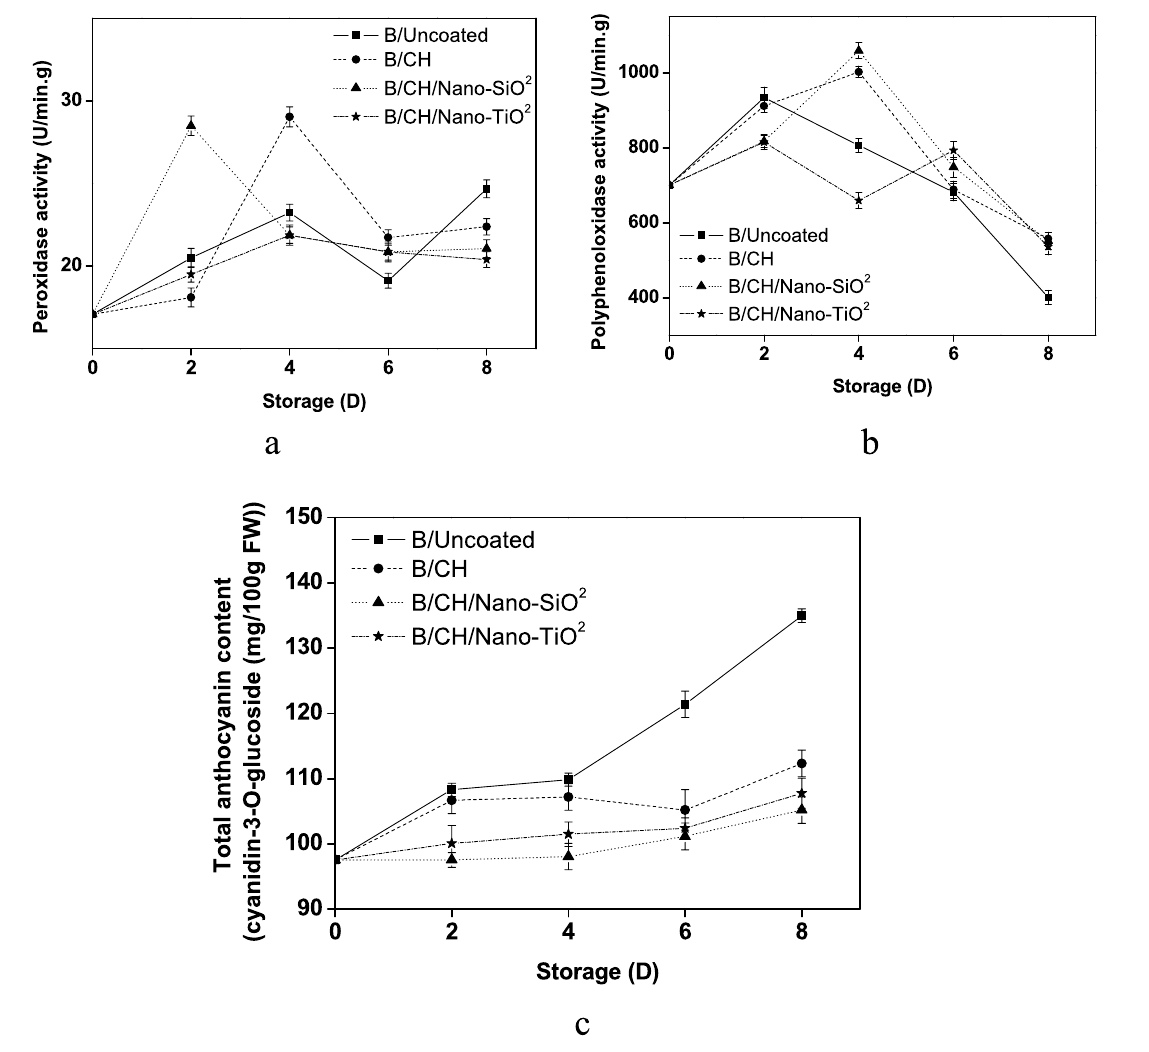
Figure 5. Effects of coating treatments on oxidation enzymes ( a , b ) and anthocyanin contents ( c